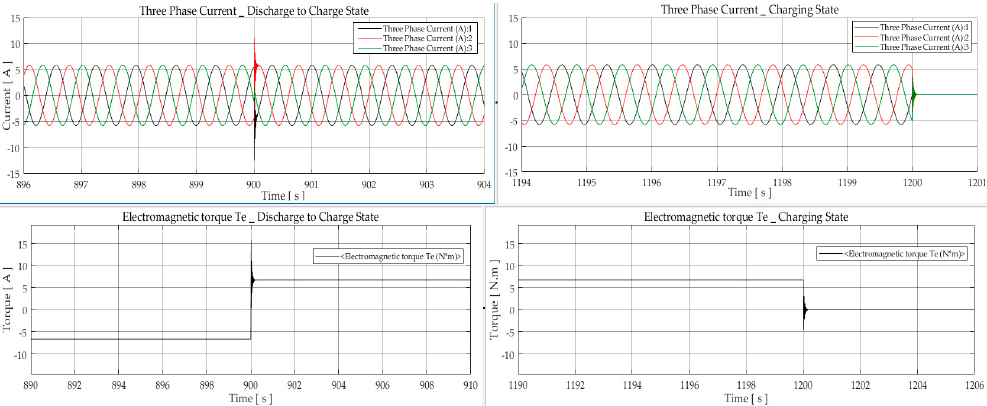
Figure 12. FESS in discharging mode: Three-phase current at t = 900 s (top left); Three-phase current at t = 1200 s (top right); Torque Te at t = 900 s (bottom left); Torque Te at t = 1200 s (bottom right).